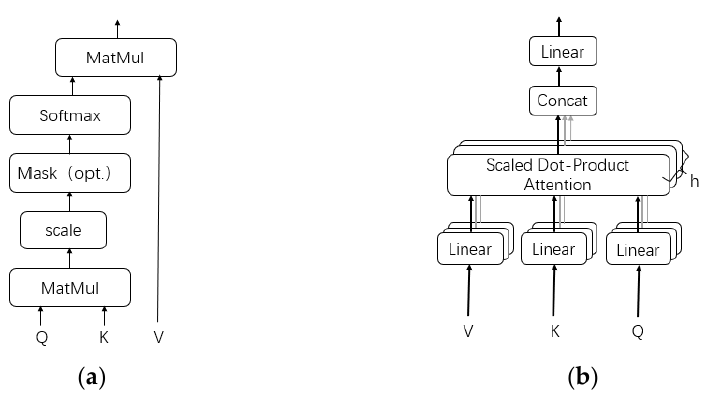
Figure 2. ( a ) Scaled dot-product attention. ( b ) Multi-head attention.